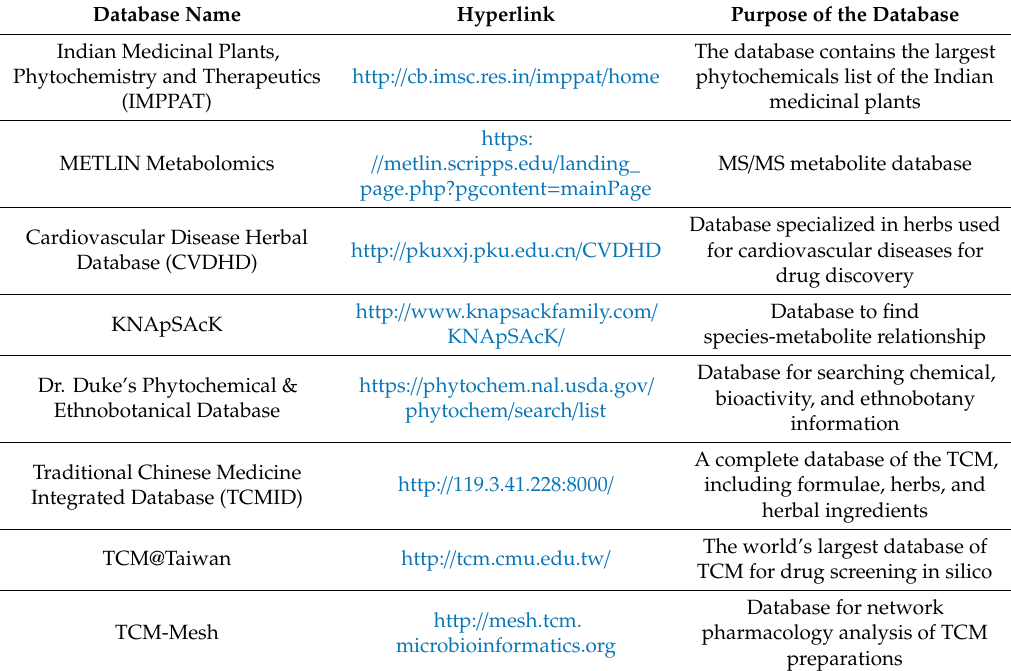
Table 1. Databases available for natural products